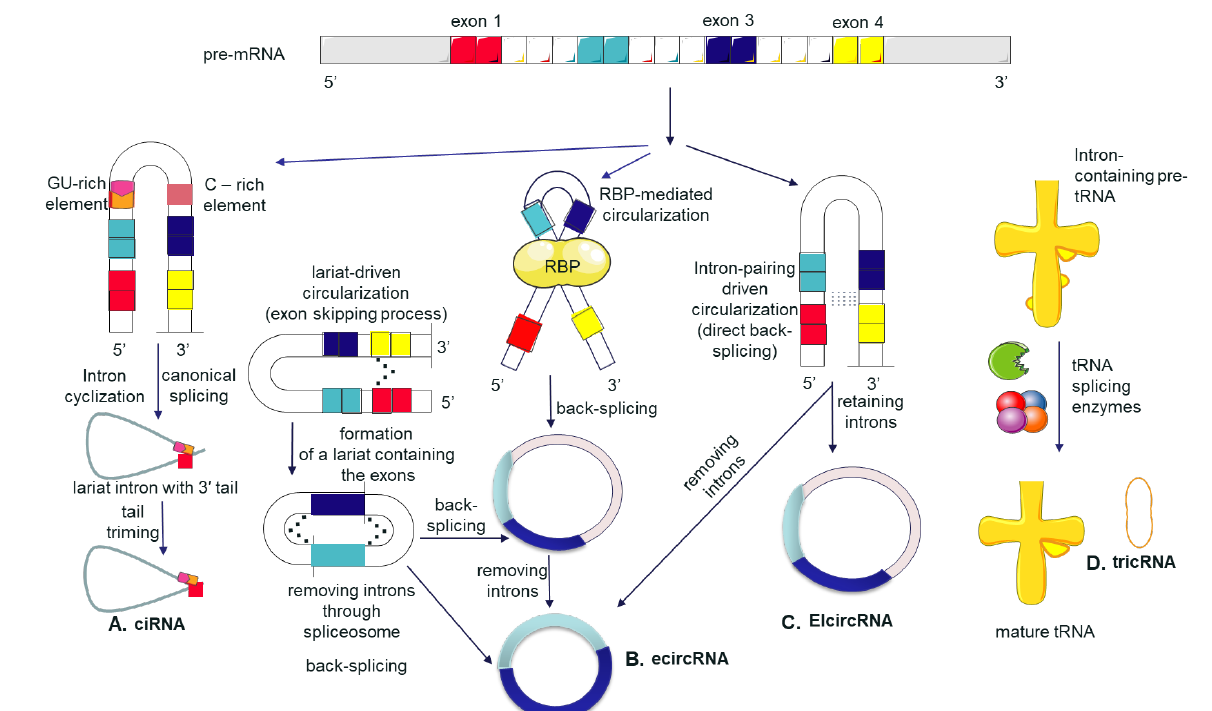
Figure 1. Overview of circRNAs biogenesis: The splicing processes of precursor messenger RNA during maturation may generate different subtypes of circRNAs containing different components from parental genes [46,47]. This splicing process is responsible for the generation of circRNAs in which an upstream acceptor exon links to a downstream donor exon known as back-splicing [26,47,48]. ( A ) Circular intronic RNAs (ciRNAs). They are the result of covalent binding between 7 nucleotide GU-rich element consensus motif near the 5′ splice site and an 11 nucleotide element rich in C close to the branchpoint site [49,50]. ( B ) Exonic circRNA (ecircRNA) RNA-binding protein (RBP)-driven circularization, which depends on sequences specific to RNA-binding proteins, can promote the interaction of the downstream intron and upstream intron, causing the formation of an ecircRNA [32]. Another possibility is when the reverse sequences from introns located on both sides of the pre-mRNA segment are connecting covalently due to complementarity (intron-pairing driven circularization) [51,52]. This possibility is supported by the finding of a tandem repeat of the ALU sequence in the lariat structure [53]. Under lariat-driven circularization, there is a formation of a lariat through exon skipping. Then, the introns are removed through spliceosome to generate ecircRNA [50]. ( C ) Exon-intron circRNAs (EIciRNA). Pairing of quaking (QKI) RNA-binding protein (RBP) may lead to the formation of EIciRNAs, which may form ecircRNA ( B ) by following removal of introns [51,54]. The more the introns include QKI motifs, the higher is the formation of circRNA. This in turn shows that the biogenesis of circRNAs may be regulated by induction or suppression by RBPs depending on the cell needs and conditions [51,55,56]. Similar to ecircRNAs ( B ), EIciRNAs can be produced by intron pairing-driven and lariat-driven circularization also. ( D ) tRNA intronic circular RNAs (tricRNAs). Pre-tRNA transcripts containing eukaryotes are cleaved by a tRNA splicing endonuclease (TSEN) complex, which catalyzes the removal of tRNA introns. This yields two exon halves and an intron. Other single enzyme joins both the exon halves and the intron ends to yield a mature tRNA and a circular intron RNA [57,58].